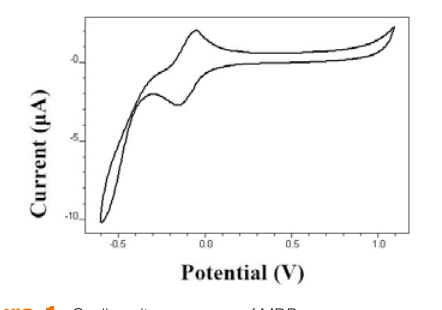
Figure 1. Cyclic voltammogram of MDB.